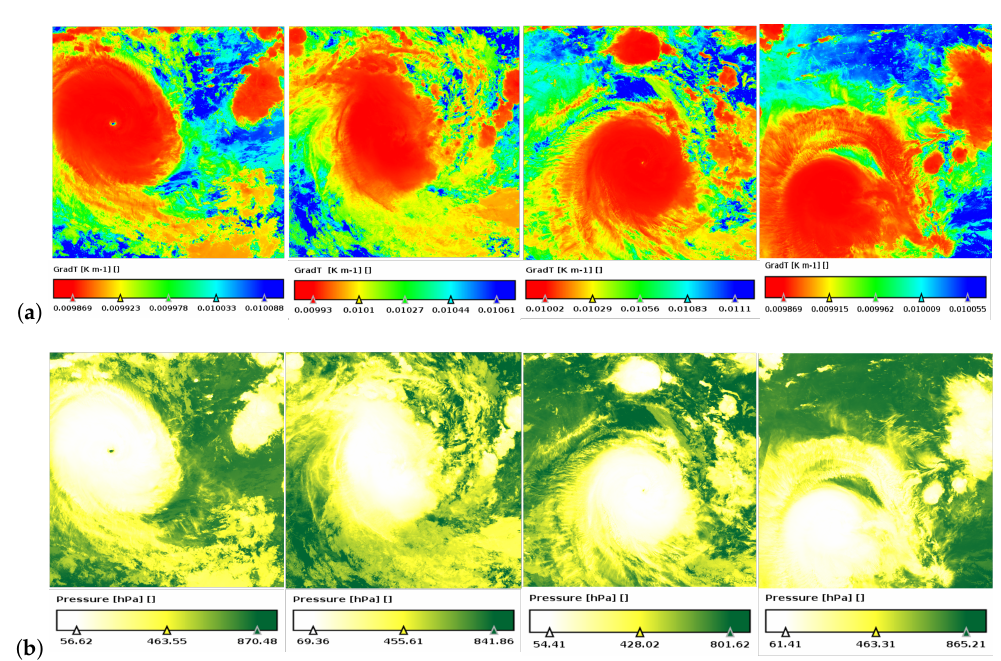
Figure 13. Temporally ordered sequence of VIIRS not-resized images, from 7 February 00.00 UTC to 11 February 00.00 UTC. Each image represents |∇ T | ( a ) and P ( b ) values, extracted in the same geographical area of ∆ R = 2400 × 2400 pixel 2 . Scene coordinates: from left to right on the top (80.00 ◦ E, 10.00 ◦ S)–(90.00 ◦ E, 10.00 ◦ S), on the bottom (80.00 ◦ E, 20.00 ◦ S)–(90.00 ◦ E, 20.00 ◦